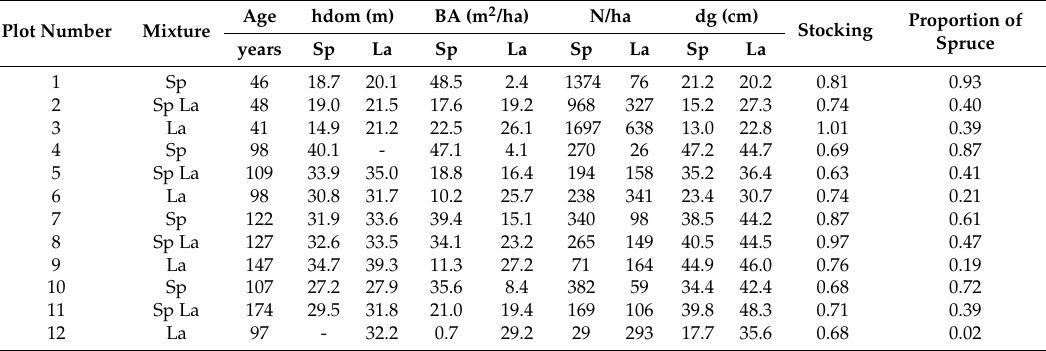
Table 2. Mean plot characteristics. Sp indicates Norway spruce, La indicates European larch, hdom is the mean height of the 100 largest trees per hectare, BA is the basal area per hectare, N/ha is the tree number per hectare, and dg is the dbh (diameter at breast height) of the tree with the mean basal area. The species proportions and the stocking degree were calculated following Dinberger’s and Sterba’s method [22] by applying the relative density index using potential densities according to Vospernik and Sterba